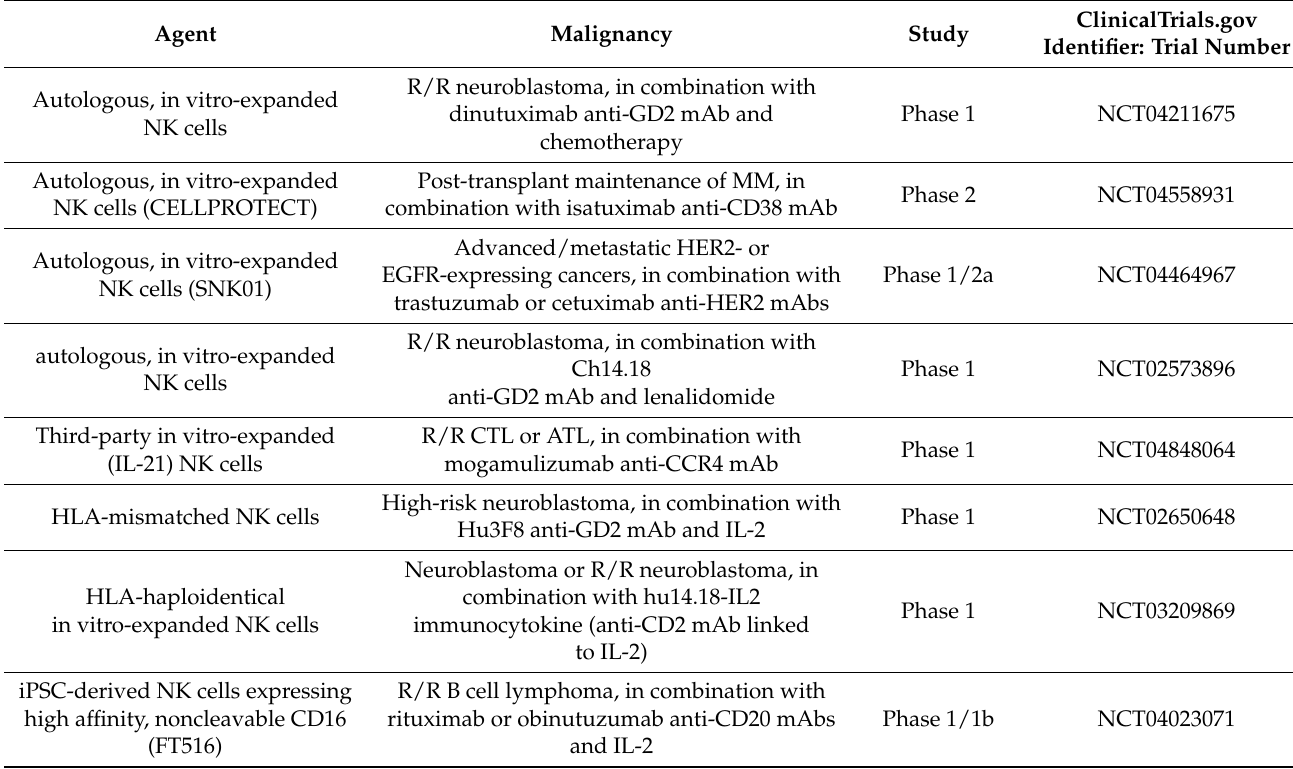
Table 2. Selected ongoing clinical trials employing adoptively transferred NK cell products to potentiate tumor-targeting mAb therapeutic efficacy. Agent Malignancy Study